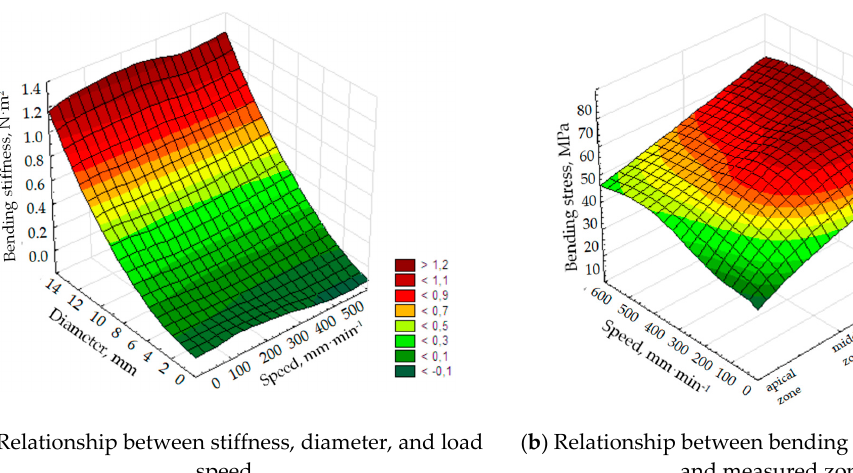
Figure 15. Characteristic features of energy crop strength properties .